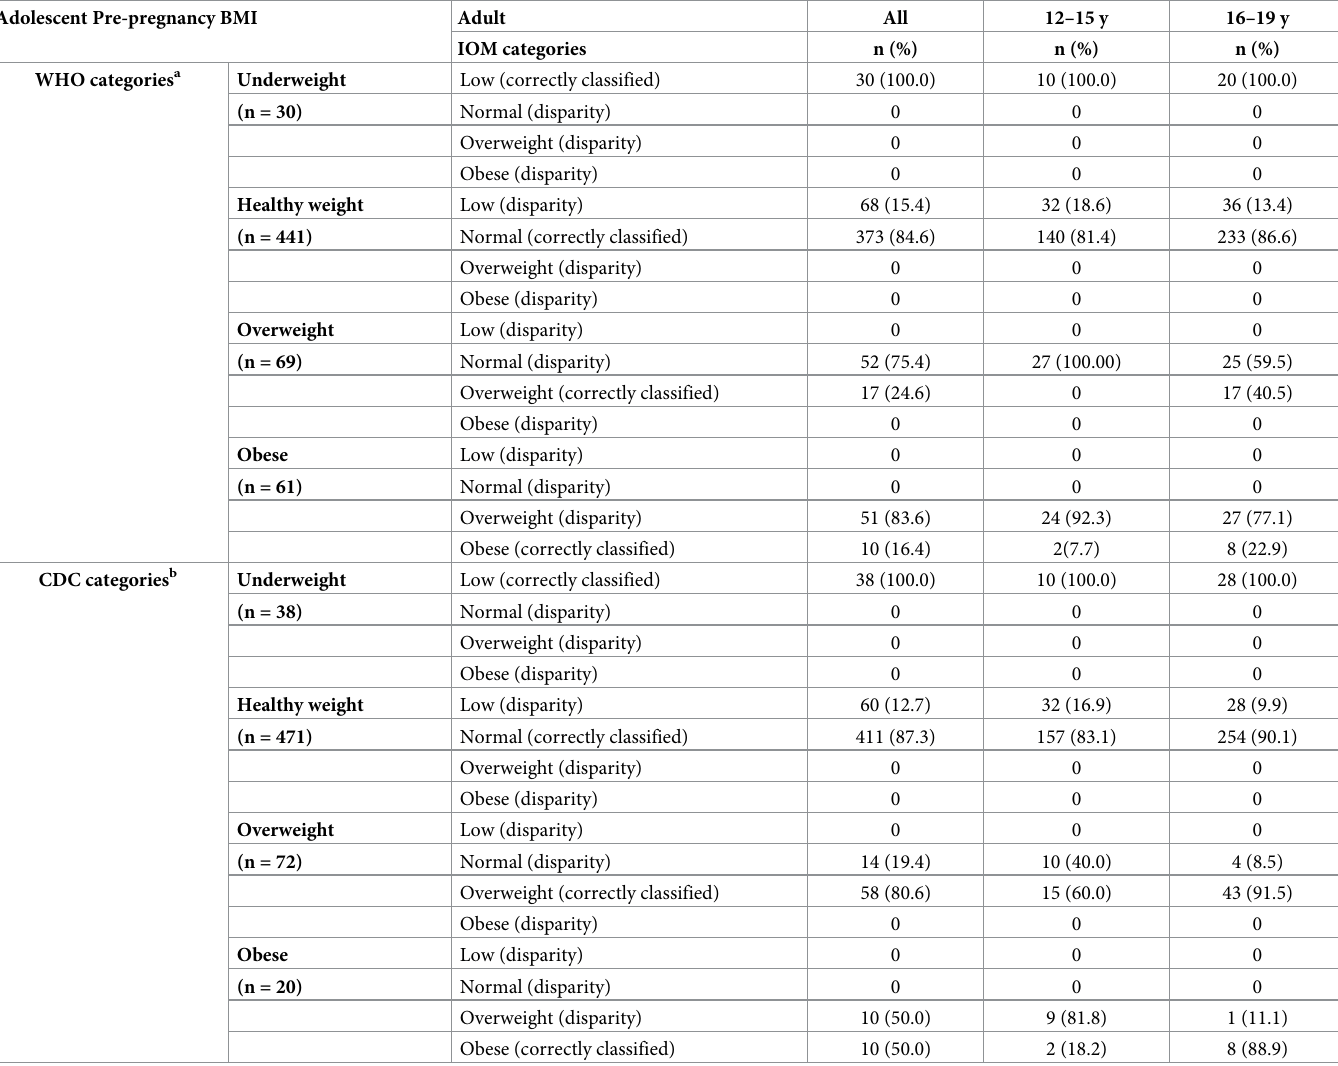
Table 3. Pre-pregnancy BMI classification disparity between adolescent vs adult